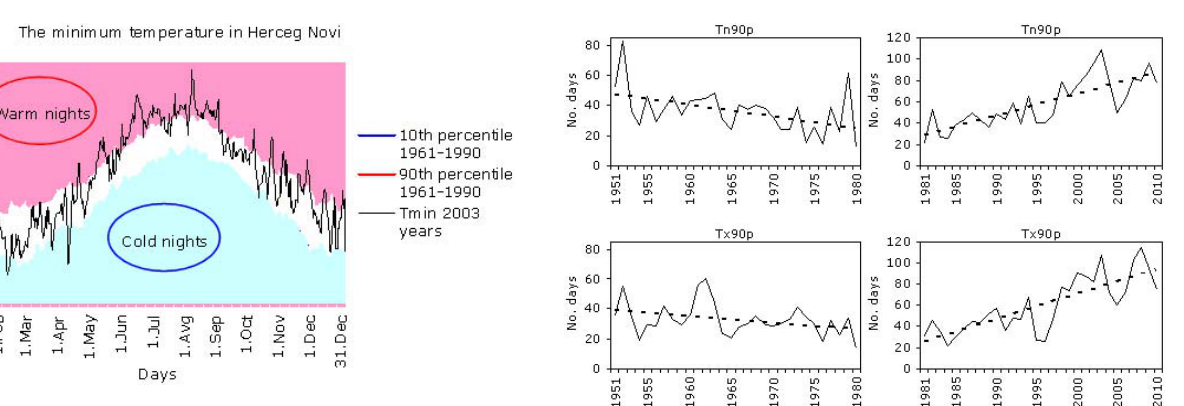
Fig. 3. Regional time series for warm nights and warm days (units: days) in (left) the 1951–1980 period and (right) the 1981–2010 pe- riod. Dashed line indicates Sen’s slope